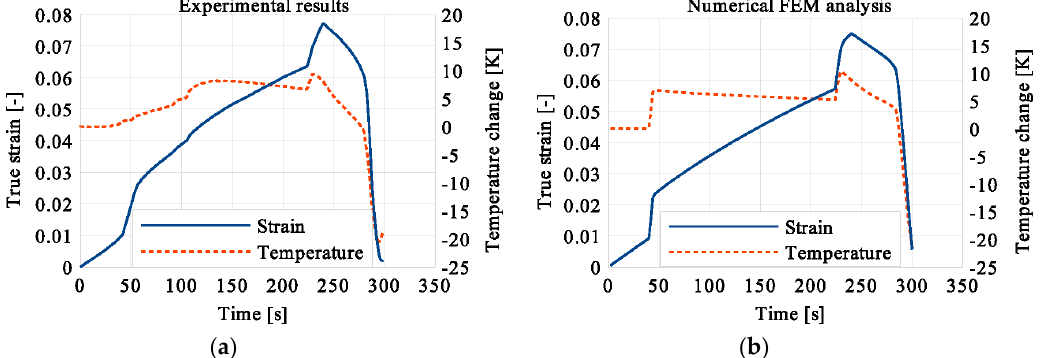
Figure 7. Strain and temperature variations vs. time for the loading program (1): 3-min loading interruption at the beginning of the LMT: ( a ) experimental; ( b ) numerical results.